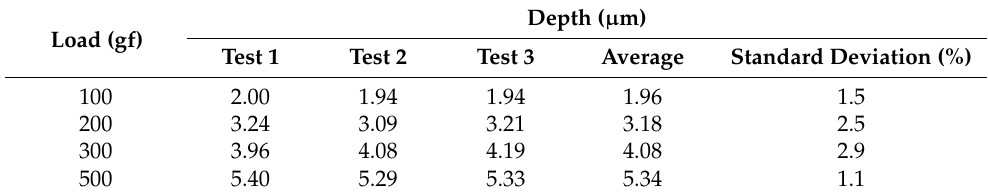
Table 3. Experimental plastic indentation depth results on the Ti/SiC MMNC coating.